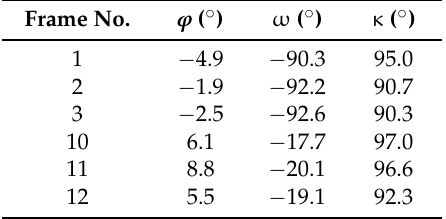
Table 3. Angular exterior orientation parameters of the video frames of the test object. Frame No.